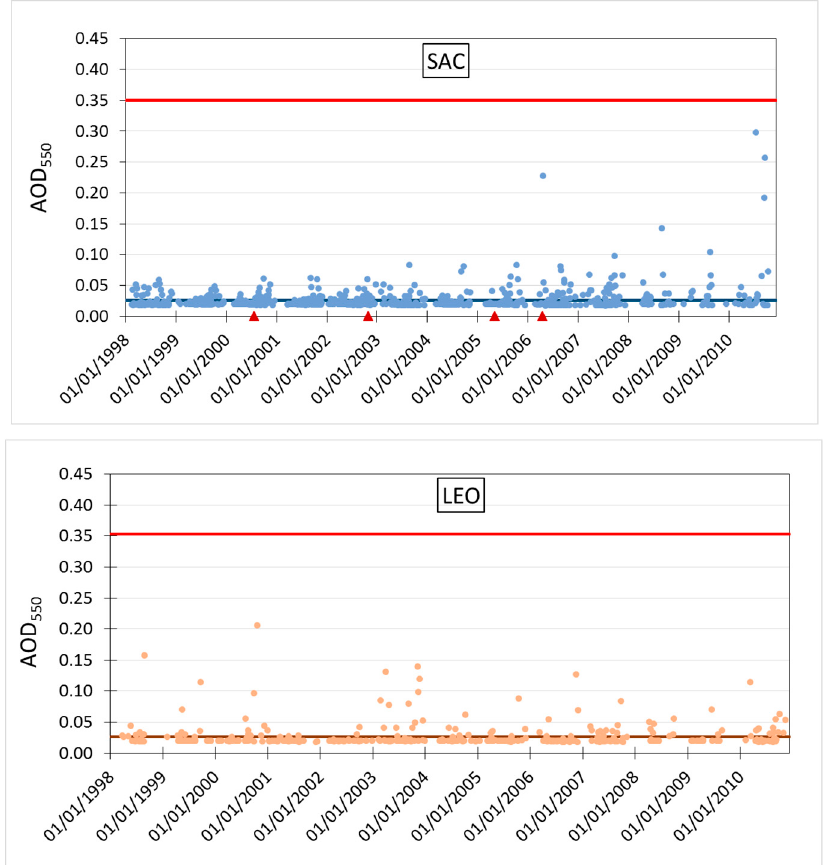
Figure 7. ( Top ) Aerosol optical depth at a wavelength of 550 nm (AOD550) measured by SeaWiFS